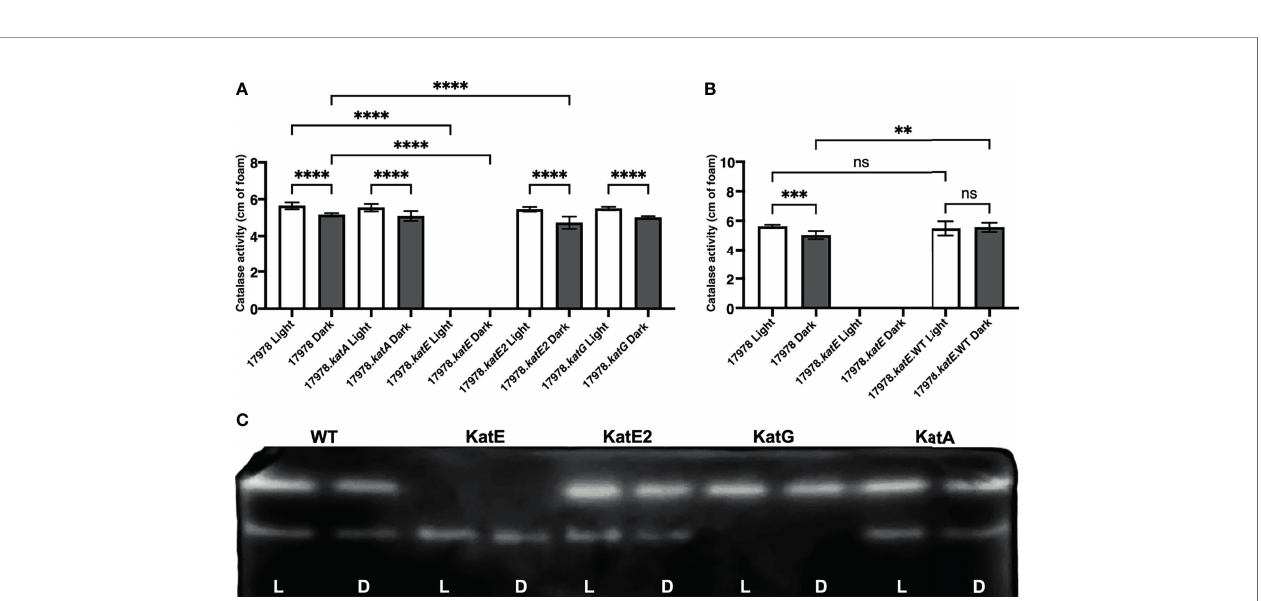
FIGURE 3 | The effect of light on catalase activity of 17978 strains. Light-dependent catalase regulation in the wildtype 17978 and isogenic catalase mutant strains. (A) Catalase activity of 17978 and katA - , katE - , katE2 - , and katG - mutant strains (17978. katA , 17978. katE , 17978. katE2 , and 17978. katG , respectively) was measured using equal numbers of bacteria that had been grown in SB under blue light or in darkness with shaking to exponential phase at 24°C. (B) Catalase activity of the complemented katE - strain (17978. katE .WT) was compared to wildtype and the isogenic katE - mutant using the same conditions described in (A) The catalase activity of each strain was analyzed using three independent biological replicates in technical triplicate ( n = 9). Error bars represent the standard deviations of the data sets. Horizontal bars with symbols indicate results of ordinary one-way ANOVA with Sidak ’ s multiple comparisons post-hoc test (** P ≤ 0.01; *** P ≤ 0.001; **** P ≤ 0.0001; ns, not signi fi cantly different). Only statistically different values are identi fi ed in the graph in panel ( A ). ( C ) Zymogram image displaying in-gel catalase activity after performing native-PAGE of equal amounts of the soluble protein from wildtype bacteria and the four kat mutants. Catalase activity was visualized after in- gel incubation with H 2 O 2 and staining with a 2% ferric chloride and 2% potassium ferric cyanide